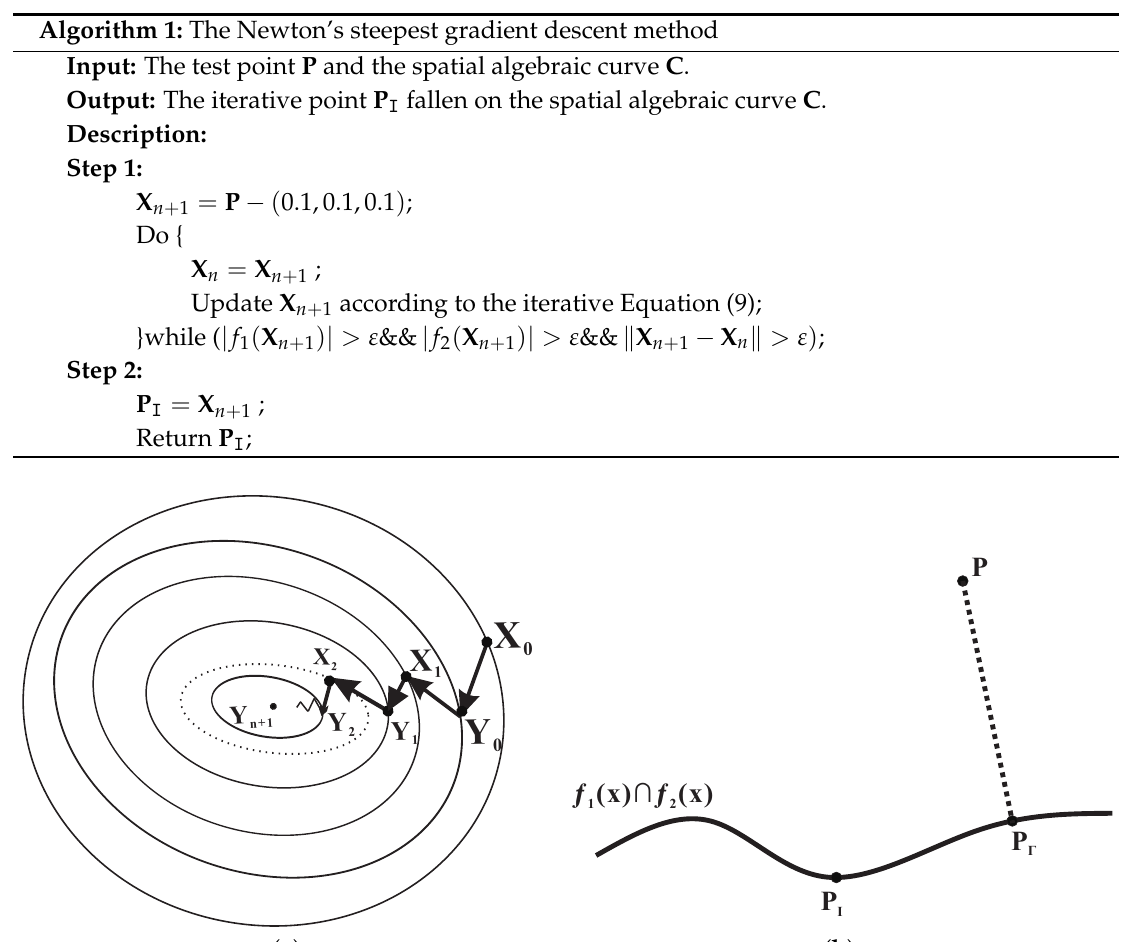
Algorithm 1: The Newton’s steepest gradient descent method